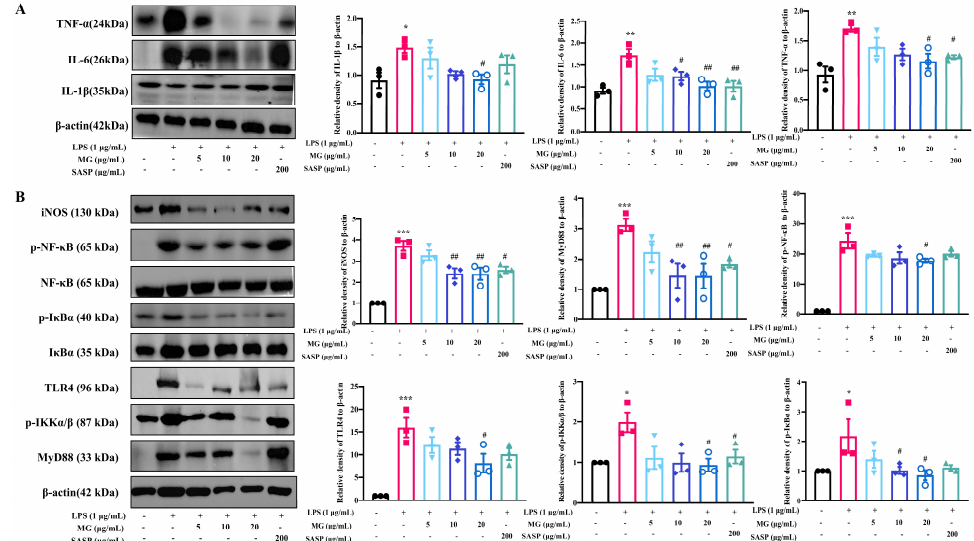
Figure 6. MG inhibites the expression of inflammatory cytokines ( A ) and TLR4/NF- κ B signaling pathway activation ( B ) in vitro . Data were presented as the means ± SEMs of three independent experiments. * p < 0.05, ** p < 0.01, and *** p < 0.001 vs. the normal group; # p < 0.05, ## p < 0.01, and ### p < 0.001 vs. the group treated with only LPS.